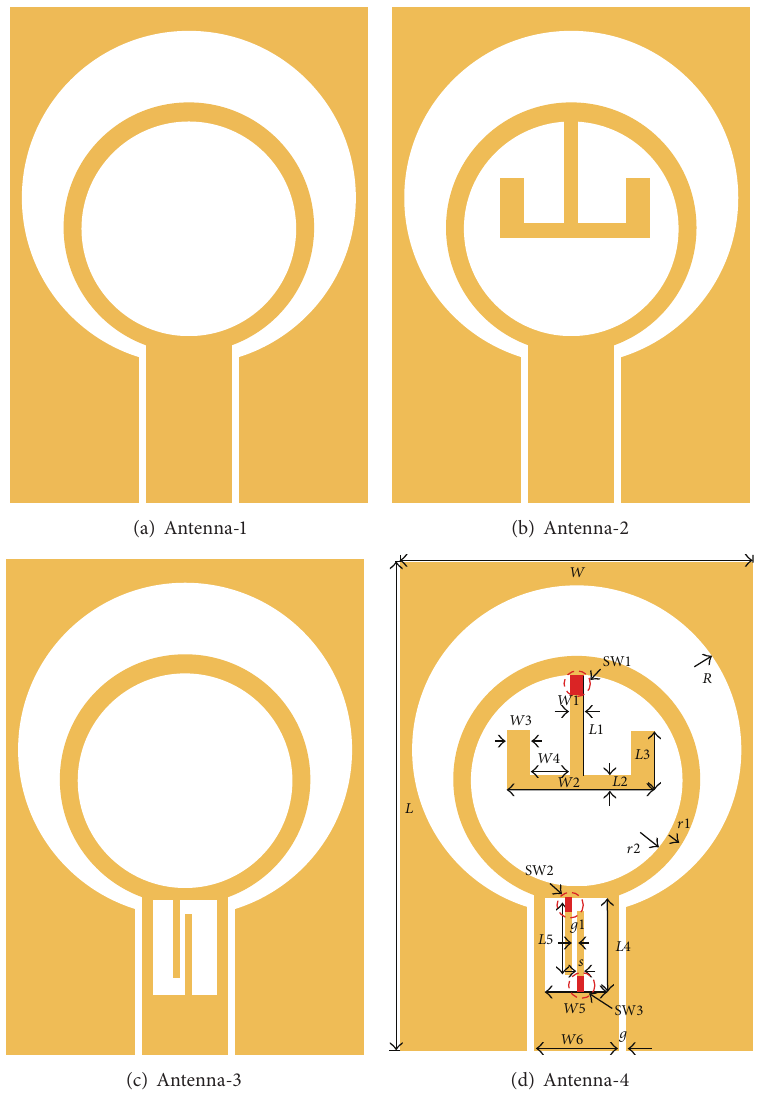
Figure 1: Design evolution and geometry of the proposed